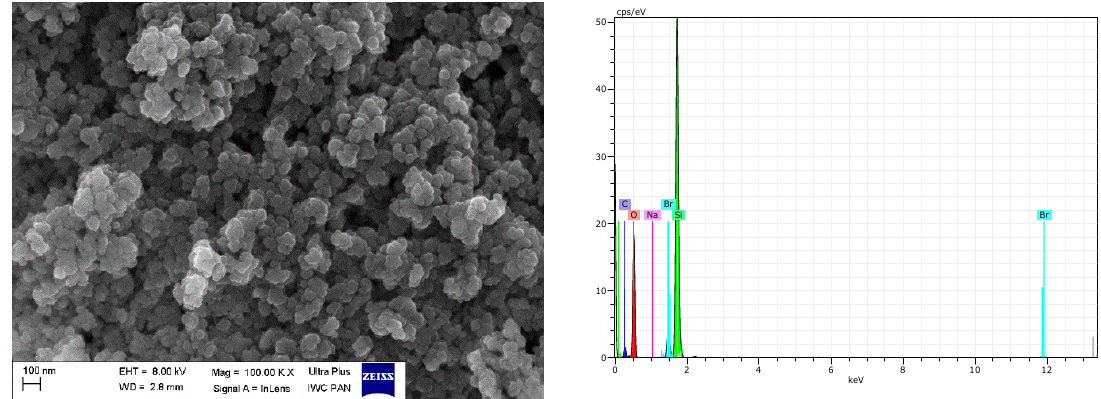
Figure 14. SEM with EDS analysis for nanoSiO 2 /IL20.